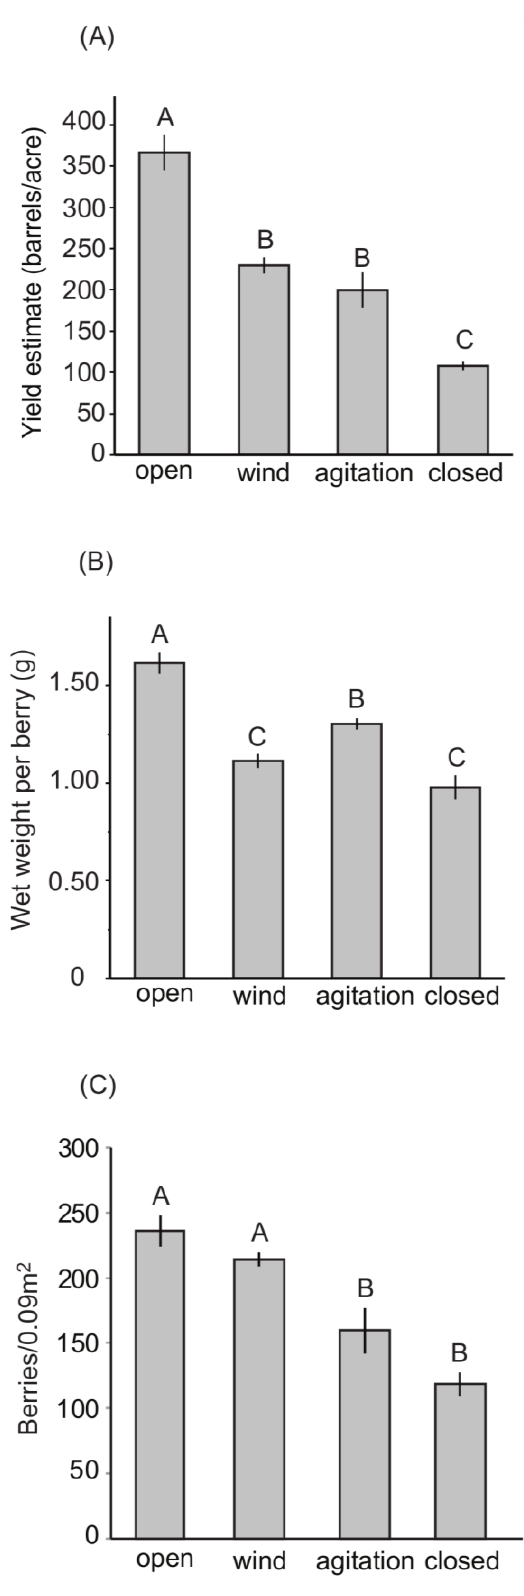
F IGURE 1: Metrics of pollination success for the cranberry cultivar “Stevens” as measured in the field: (A) yield estimate (mean ± SE), (B) wet weight per berry (mean ± SE), and (C) number of berries per 0.09 m 2 plot (mean ± SE). Letters represent significant differences (P < 0.05) between treatments. Note that 1 barrel/acre = 111